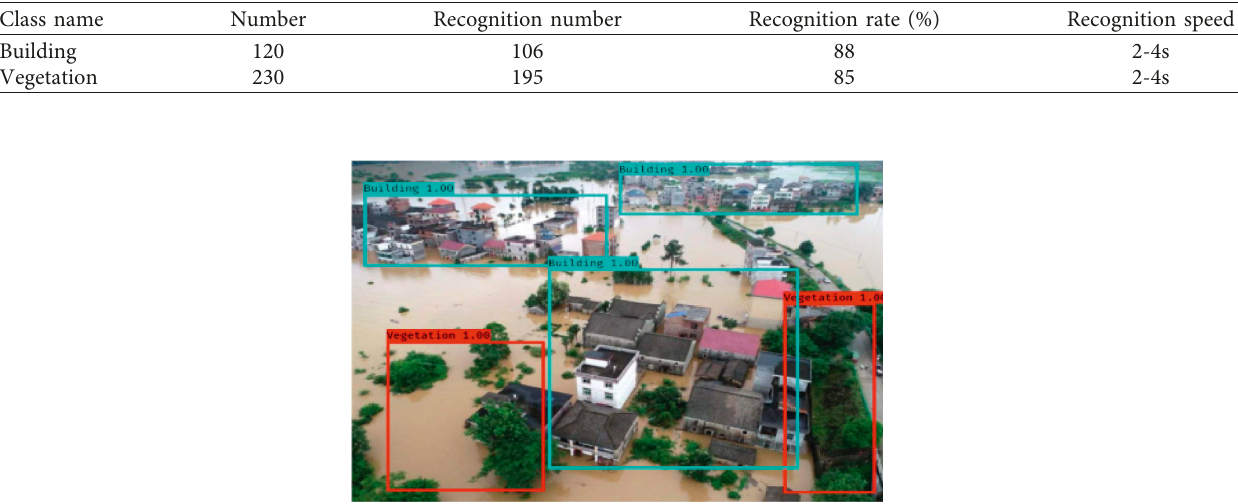
Table 3: Objects’ recognition rate.